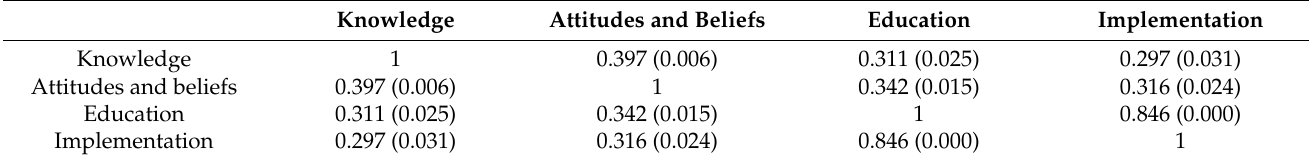
Table 5. Correlation